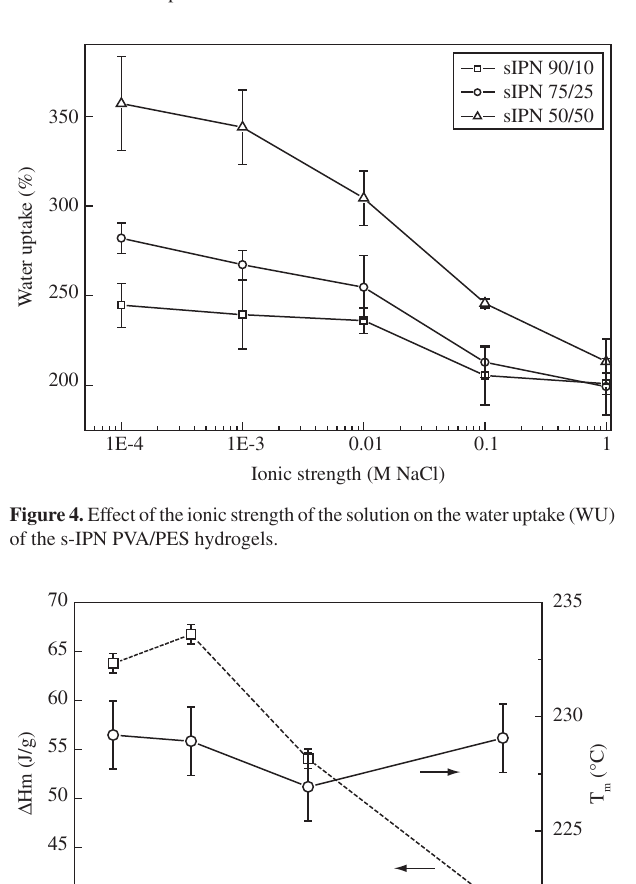
Figure 5. Effect of the PES content on the T hydrogels.